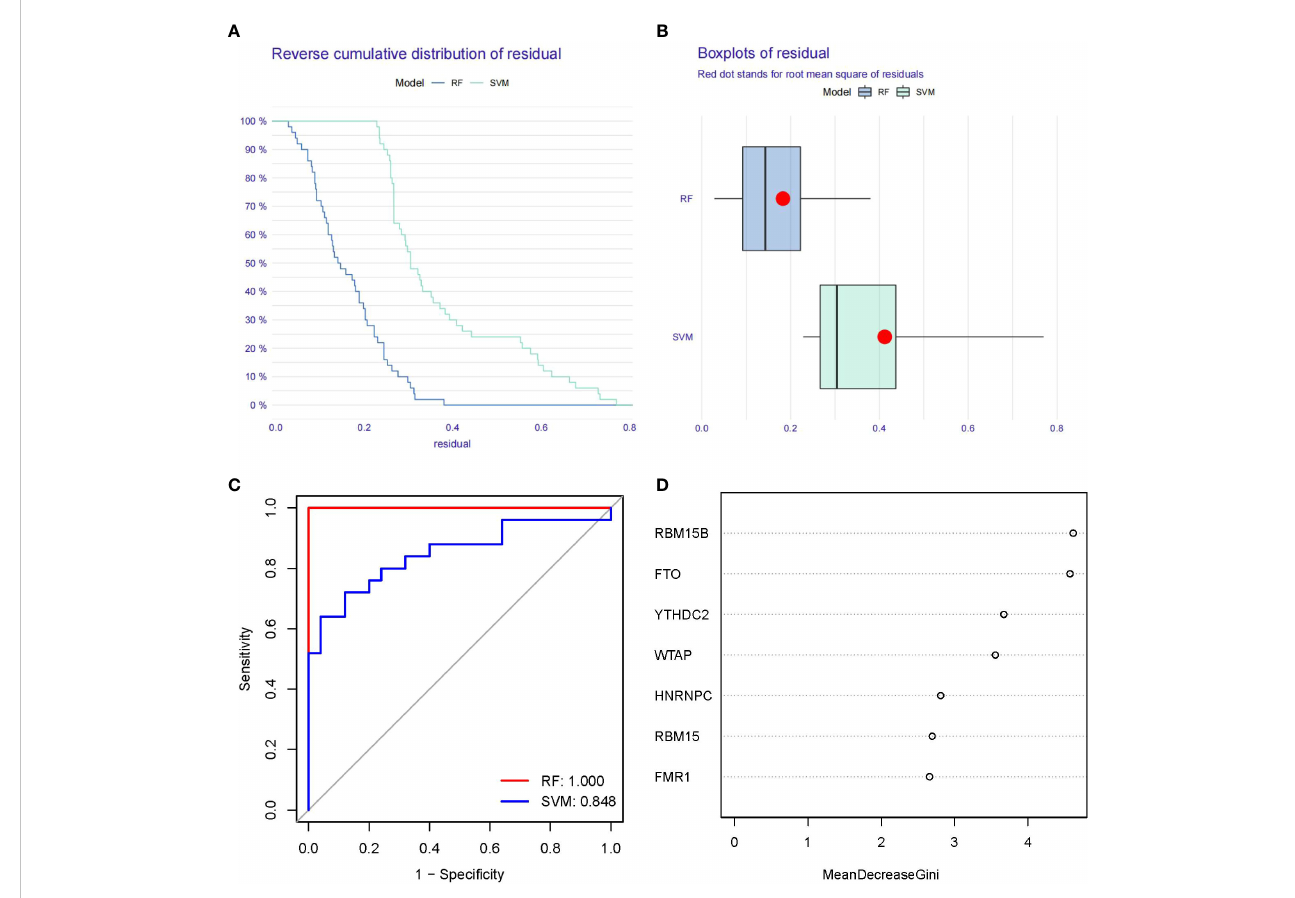
FIGURE 4 Establishment of the RF and SVM Models. (A) Reverse cumulative distribution of residual was constructed to display the residual distribution of RF and SVM models. (B) Boxplots of residual was construct to display the residual distribution of RF and SVM models. (C) ROC curves indicated the accuracy of the RF and SVM models. (D) The importance score of the 7 m6A modulators on the basis of the RF